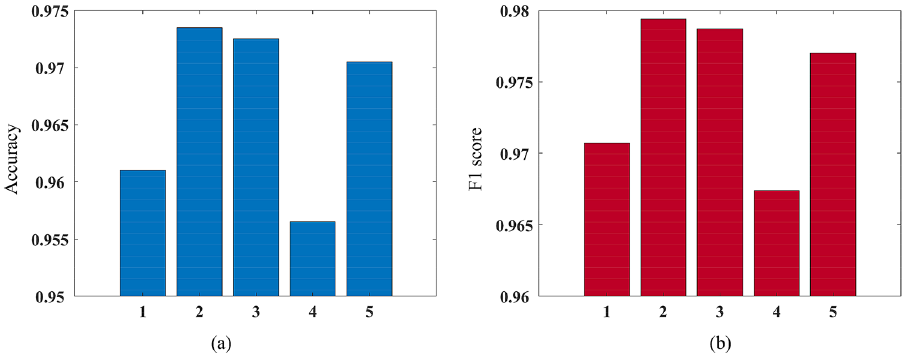
Figure 7. The accuracy and F1 score of networks with different inputs: ( a ) accuracy; ( b ) F1 score. Where 1 represents the network input as [T s , Q, SOC, T amb ], 2 represents input as [T s , Q, SOC, T amb . ΔT s ], 3 represents input as [T s , Q, SOC, T amb , ΔT s , ΔQ], 4 represents input as [T s , Q, SOC, T amb , ΔT s , ΔSOC], and 5 represents input as [T s , Q, SOC, T amb , ΔT s , ΔQ,